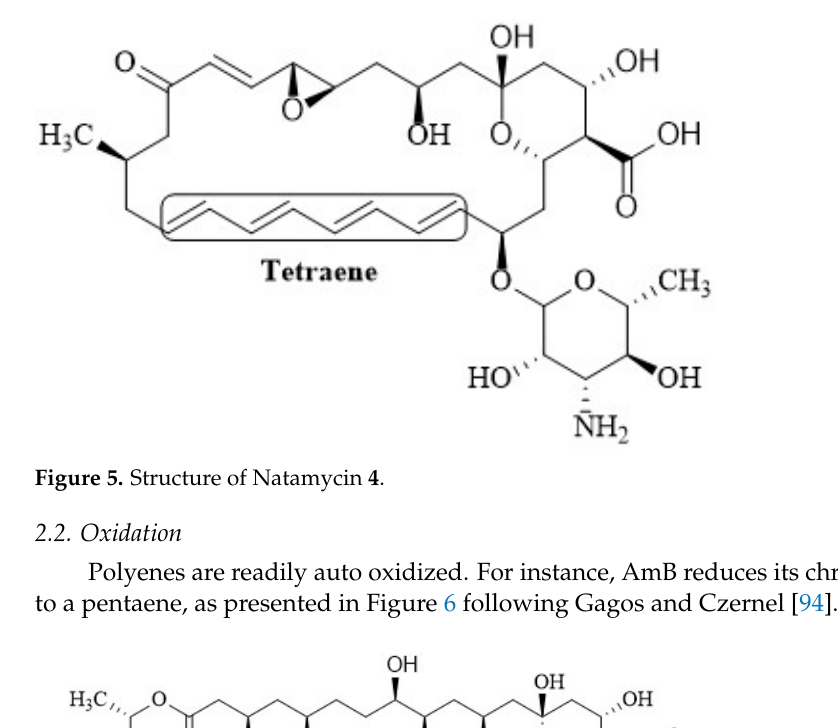
Figure 5. Structure of Natamycin 4 .